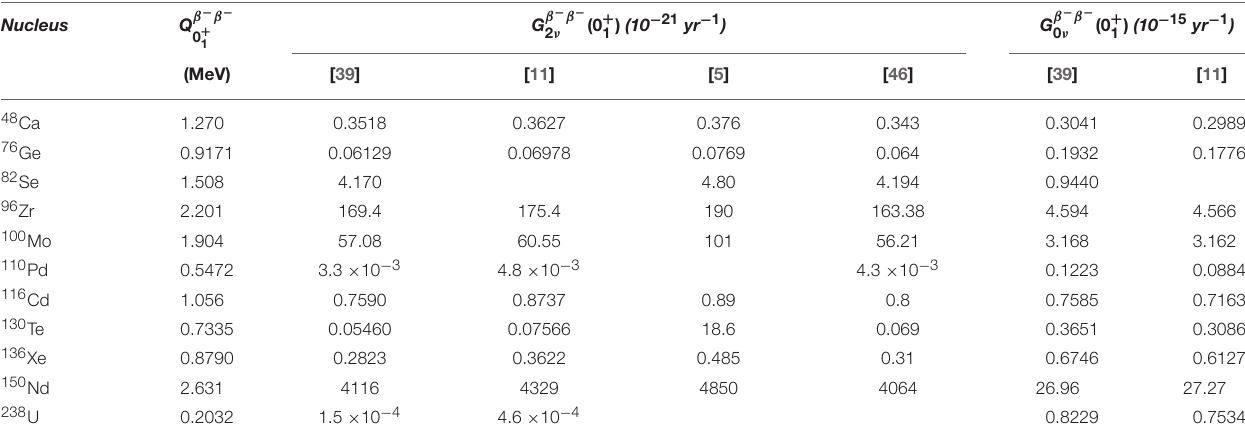
TABLE 3 | PSF for β − β − decays to final excited 0 + 1 states. Nucleus